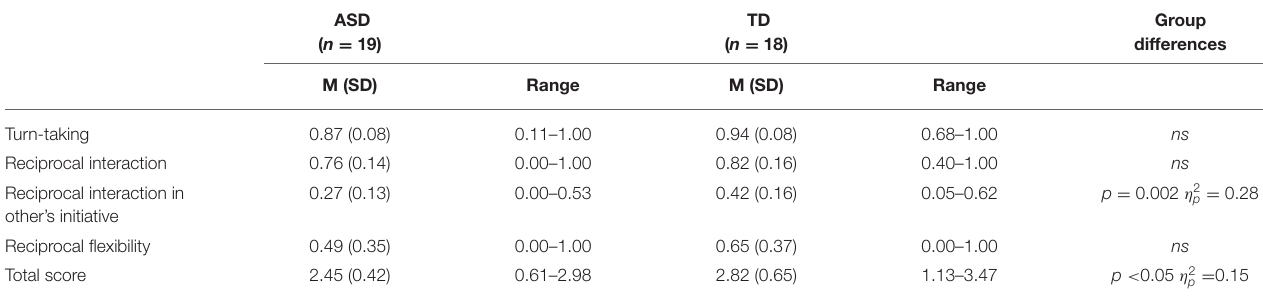
TABLE 5 | IDT scores of the ASD and TD group, controlled for verbal receptive